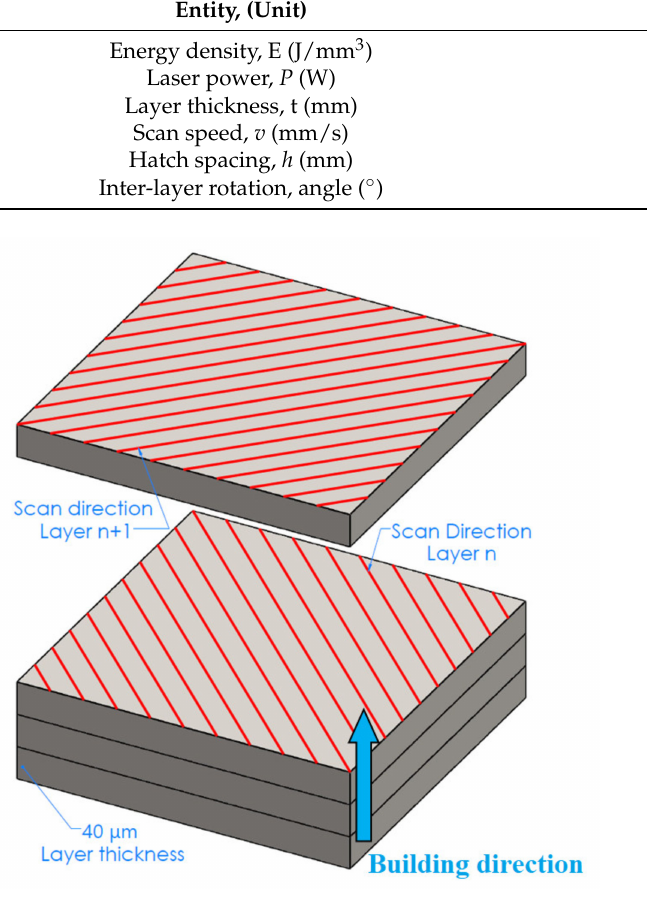
Figure 1. Graphical representation of interlayer rotation between adjacent layers.